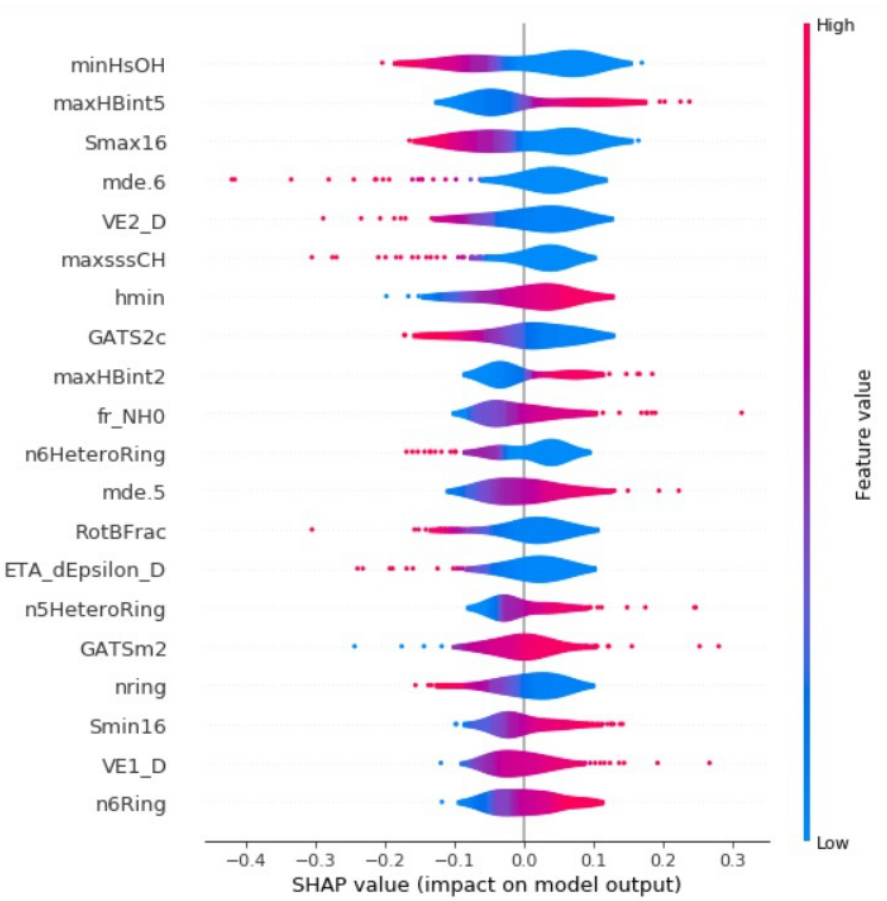
Figure 7. SHAP summary plot displays the distribution of top 20 important descriptors used for training the proposed model for hepatotoxicity